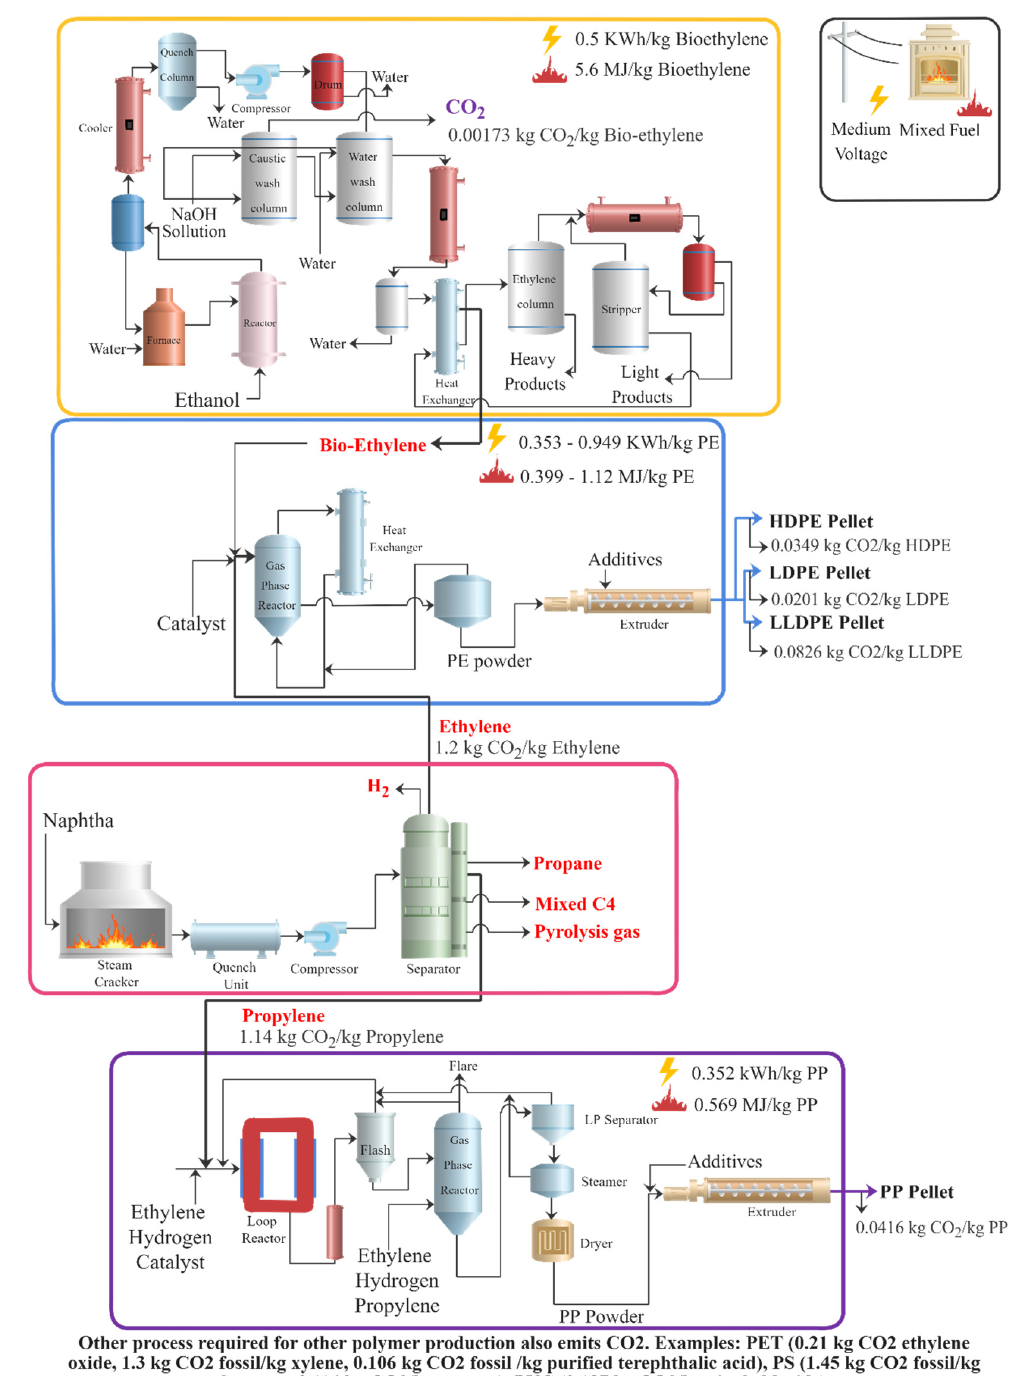
Figure A1. Detailed energy consumption and CO 2 emissions for polyethylene and polypropylene production chains (data from the Ecoivent 3.6 dataset [56]).